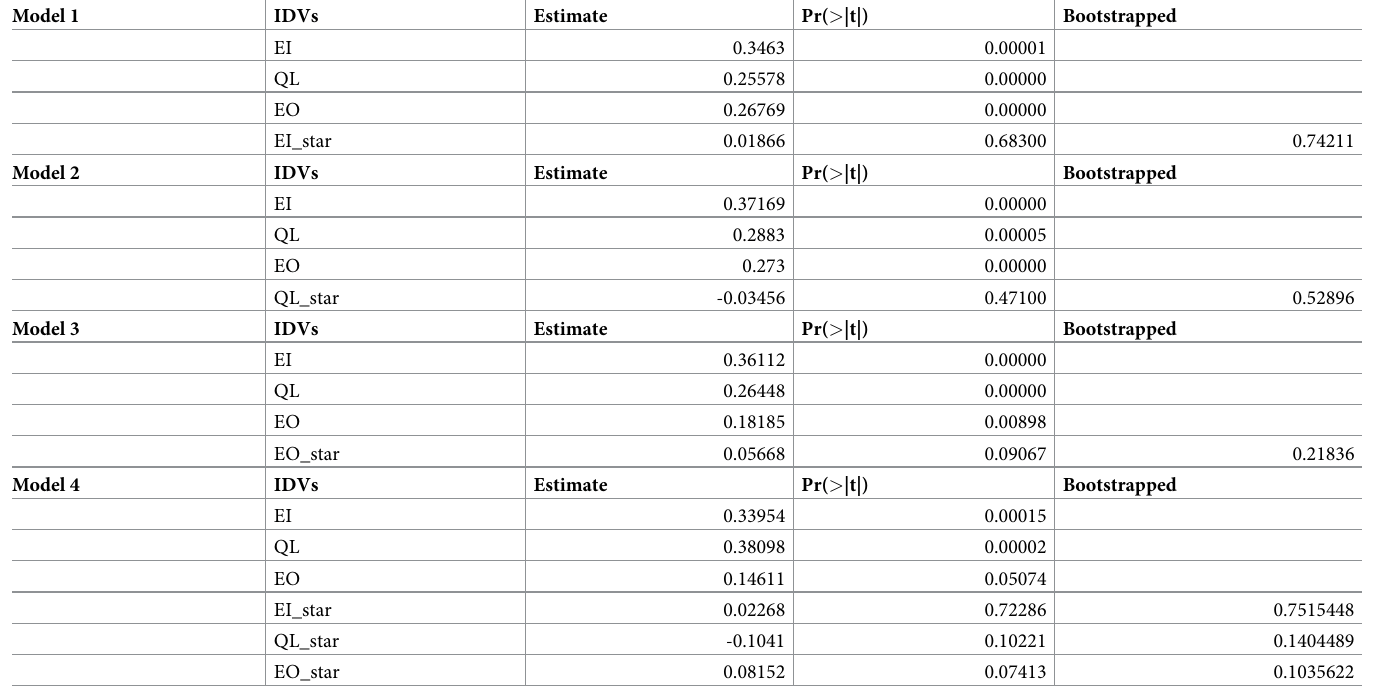
Table 8. Assessment of endogeneity test using the gaussian copula approach. Model